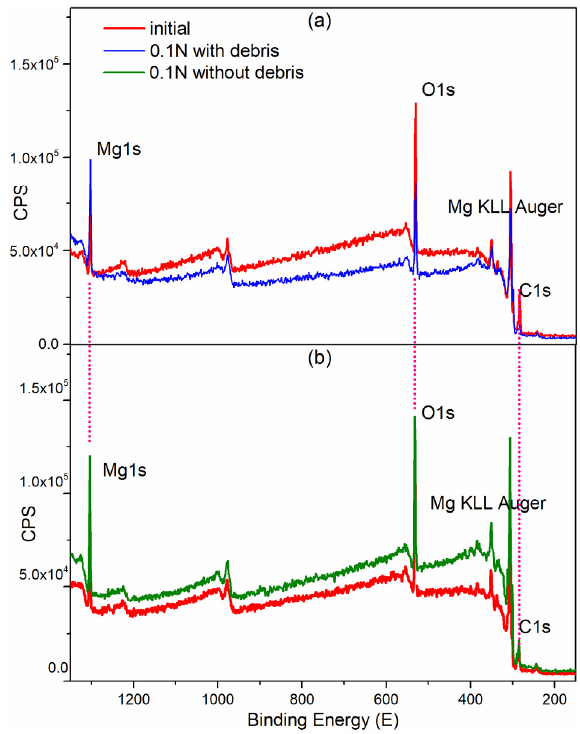
Figure 9. Binding energies of the XPS survey of the ( a ) worn surface with debris and ( b ) worn surface without debris.